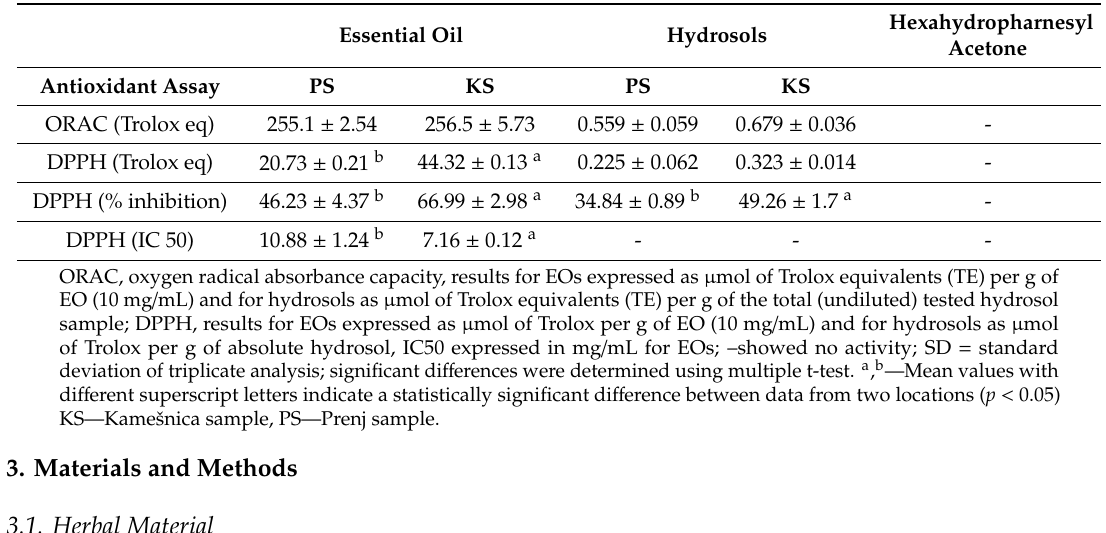
Table 5. Antioxidant potential of V. saturejoides essential oil and hydrosol determined by ORAC and DPPH method. Essential Oil Hydrosols Antioxidant Assay